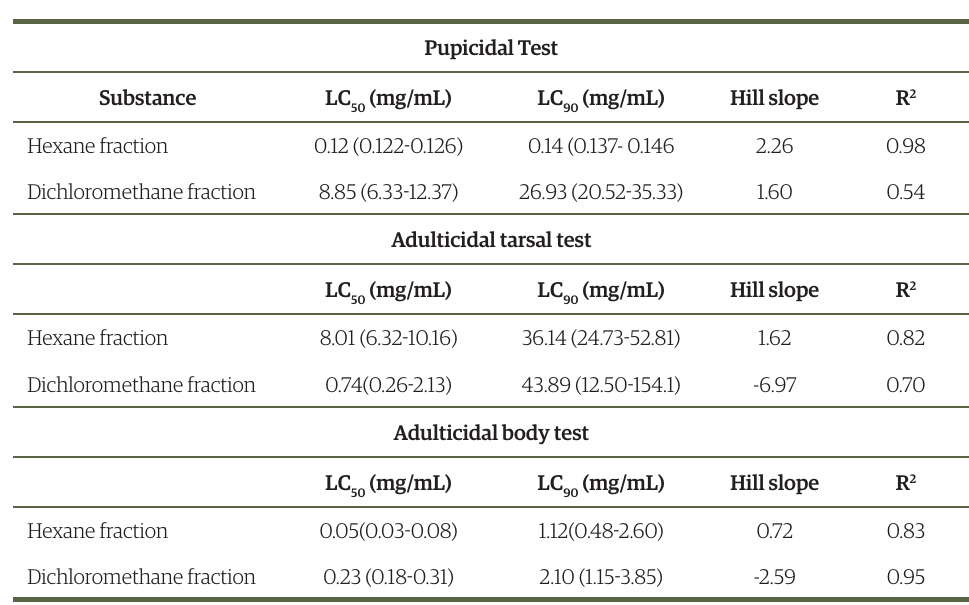
Figure 10. Landing inhibition percentage provided by the CEE, fractions and substances isolated from Helicteres velutina on females of Aedes. aegypti . Bars with * are significantly different in relation to the positive control (DEET 15%) and bars with the same letter are significantly different by Tukey test, p value < 0.05. Table 1. Statistical details of the lethal concentration 50 and